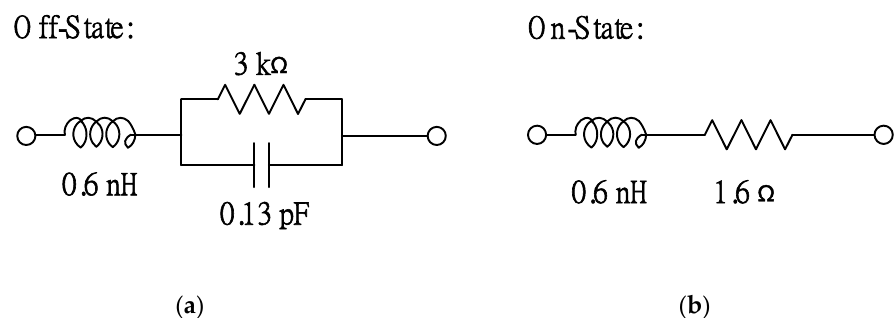
Figure 4. Equivalent circuit models of the diode when it is in the ( a ) off-state and ( b ) on-state. Table 2. Switching states of the diodes and the generated polarization modes.